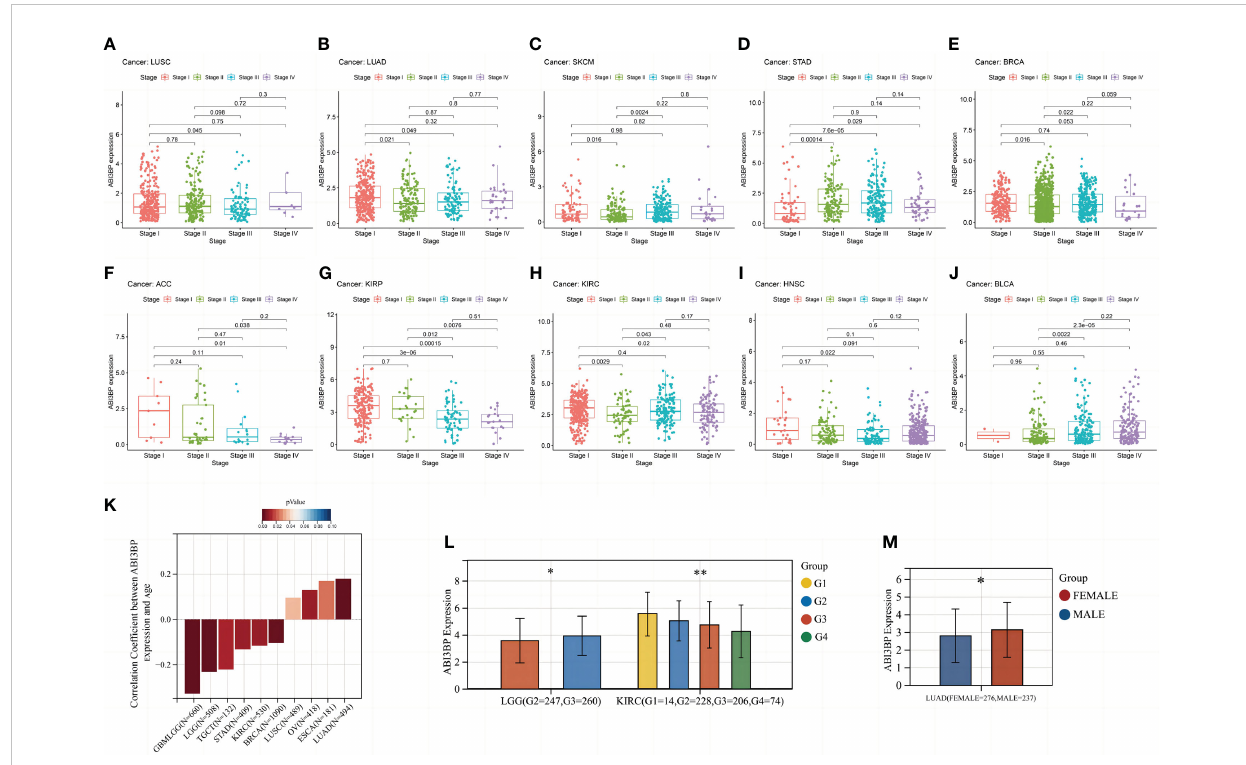
FIGURE 5 Relationship between ABI3BP and clinical case data in pan-cancer. (A-J) ABI3BP expression in LUSC, LUAD, SKCM, STAD, BRCA, ACC, KIRP, KIRC, HNSC, BLCA cancer stages. (K) Relationship between ABI3BP expression and age in different cancers. (L) ABI3BP expression in different G stages of cancer. (M) Relationship between ABI3BP expression and sex in LUAD. *, p < 0.05; **, p <